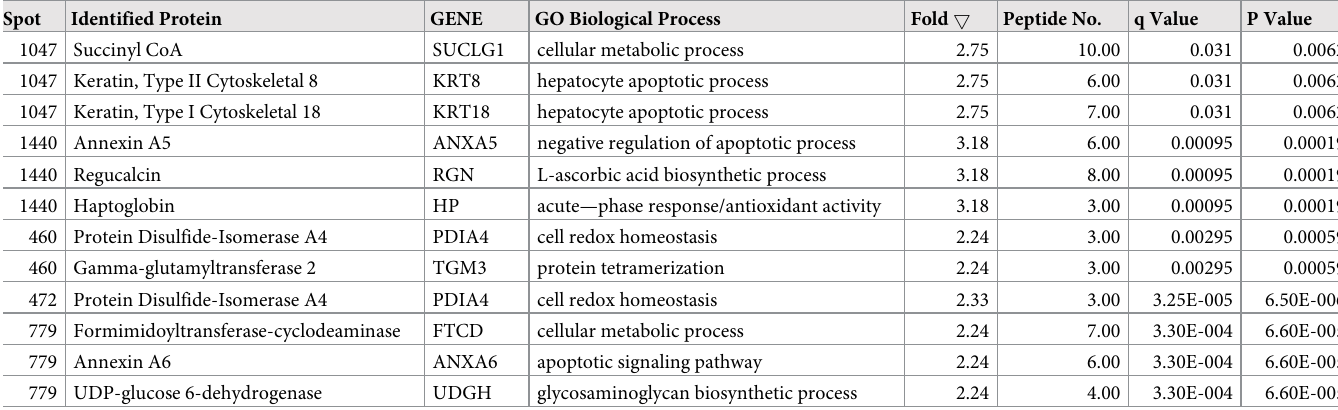
(Table 1). For protein disulfide–isomerase A4, from spot 472 a 2.33-fold increase was detected (q = 0.0000325). Additionally, we found a 2.24-fold increase in abundance of spot 779 that contained formimidoyltransferase-cyclodeaminase isoform X1, annexin A6, and UDP-glucose 6-dehydrogenase (q = 0.00033) (Table 2). Analysis of cytokeratin 18 and annexin 5 in the liver of dogs with chronic hepatitis using immunoblotting. Two proteins were selected for Western blot analysis. The proteins, cytokeratin 18 and annexin 5 were confirmed to contribute to the increased relative abun- dance in the liver proteome of dogs with chronic hepatitis (n = 7, n = 4) compared to healthy Table 2. Summary of proteins identified from differentially expressed